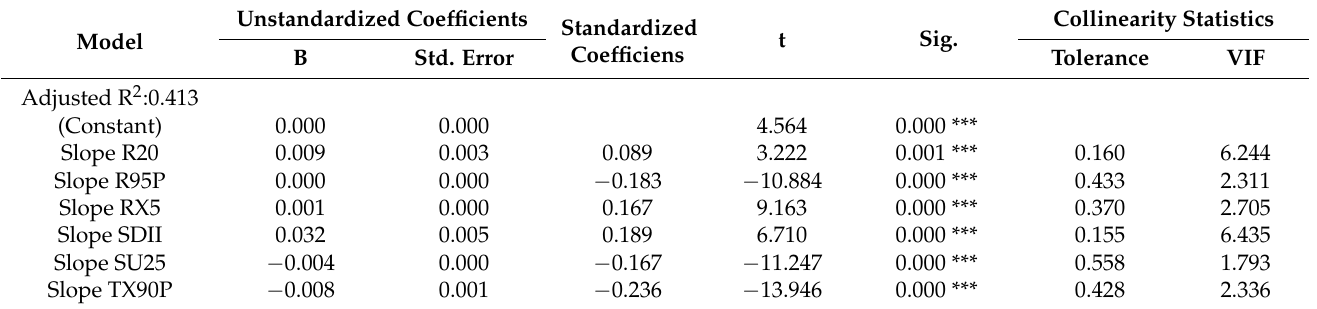
Table 4. Model of the impact of extreme climate on the normalized difference vegetation index (NDVI) of desert